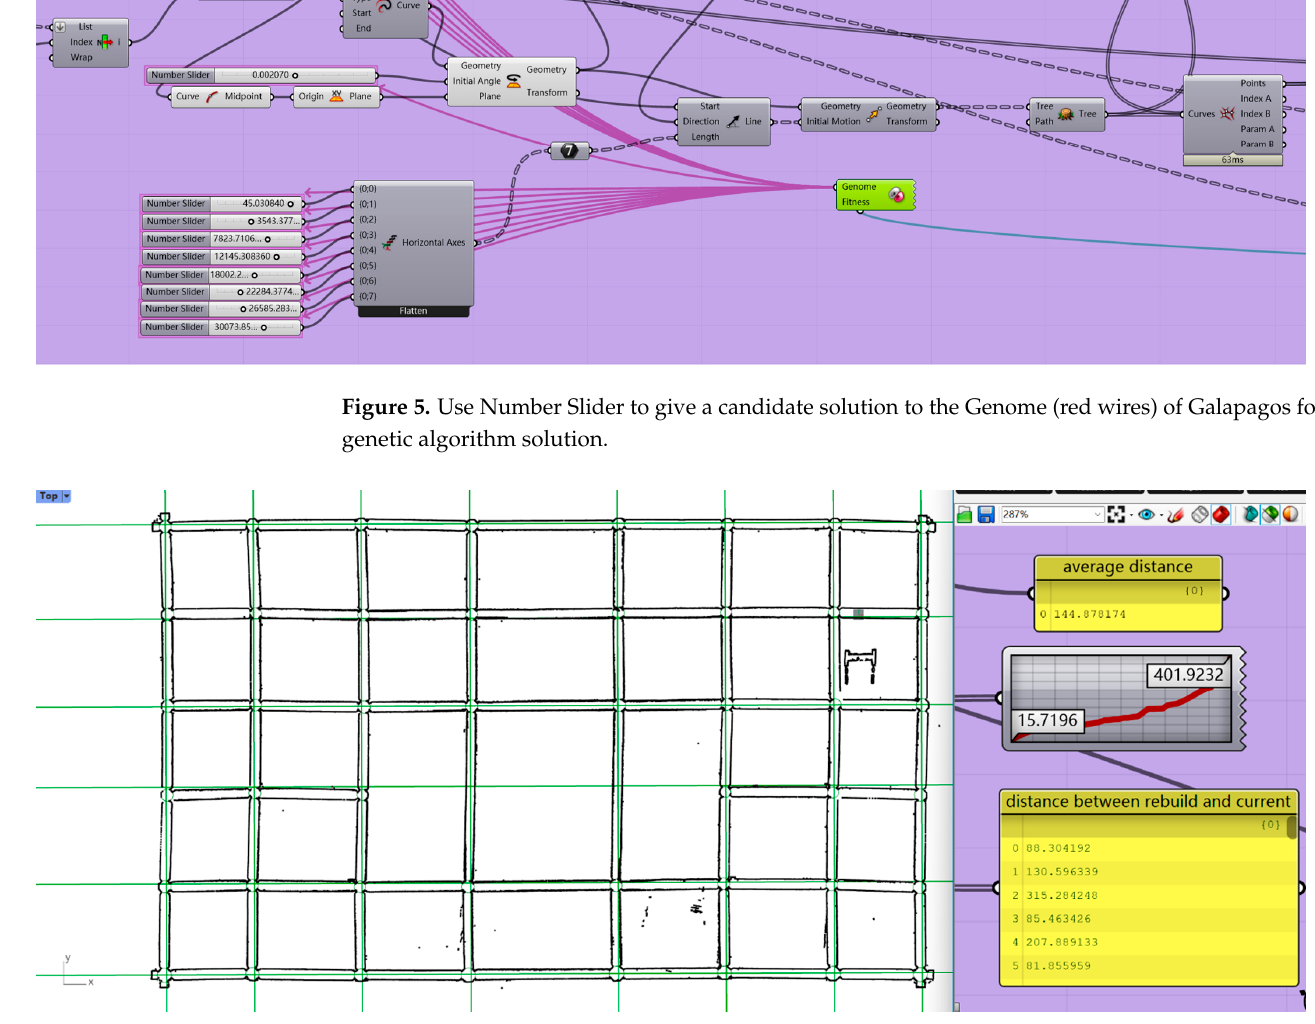
Figure 6. A candidate solution of generating axes and numerical analysis of this moment.